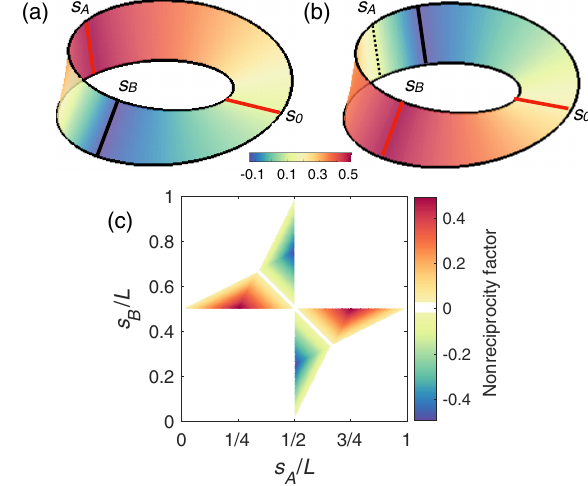
FIG. 4. Nonreciprocal response to shear stress. A Möbius strip is sheared by a localized stress distribution σ 0 ¼ σδ ð s − s 0 Þ with σ ¼ K and s 0 . (a) Overall excess shear deformations θ s Þ 0 ¼ A ð due to an additional stress σ A ¼ σδ ð s − s A Þ applied at s A ¼ 7 = 16 . (b) Plot of the excess shear deformations θ B ð s Þ measured when σ σ σδ ð s − s s 23 = 32 ). A is released and B ¼ B Þ is applied at ( B ¼ Same color map as in (a). Together, the plots reveal that θ s ≠ θ s A ð B Þ B ð A Þ . (c) Variations of the nonreciprocity factor s Δ θ as a function of the locations of s A and B . The finite value of Δ θ over a finite region of space proves that the Maxwell-Betti theorem breaks down on nonorientable elastic surfaces: Non- orientable elasticity is nonreciprocal.